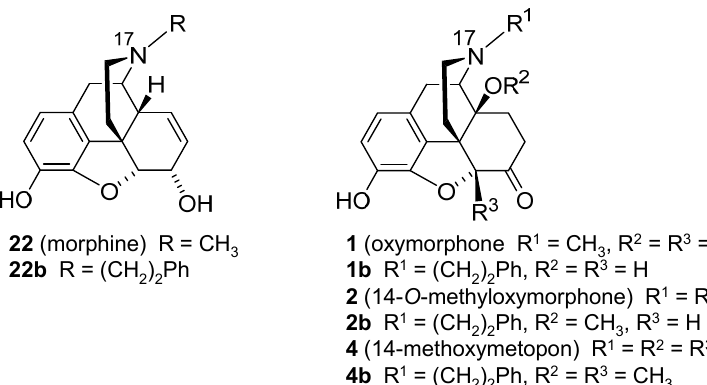
Figure 3. Structures of N -methylmorphinans morphine ( 22 ), oxymorphone ( 1 ), 14- O -methyoxymorphone ( 2 ) and 14-methoxymetopon ( 4 ), and their N -phenethyl counterparts 22b , 1b , 2b and 4b , respectively. Ph, phenyl.